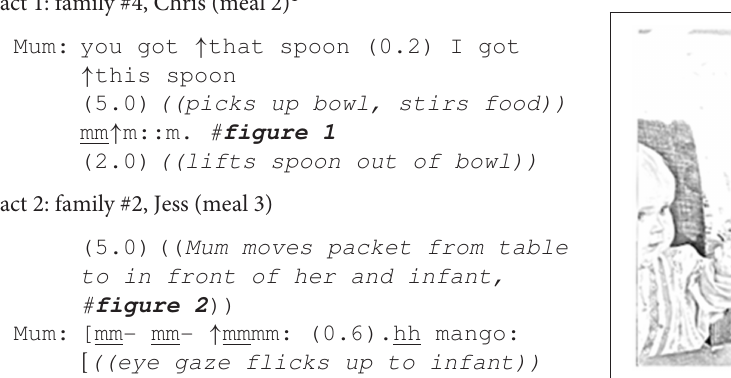
FIGURE 2 | Image published with the written informed consent of the depicted adult and of the parents of the depicted